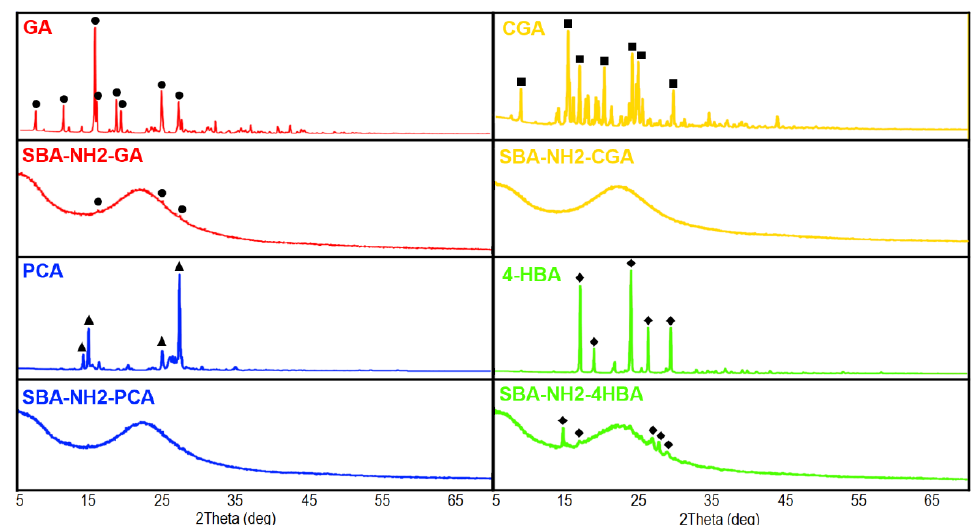
Figure 4. The XRD patterns of antioxidant-loaded SBA-NH2 materials with the antioxidant refer- ence samples. Table 4. The amount of antioxidants desorbed from the SBA-NH2 material determined using the HPLC and FC methods with antioxidant